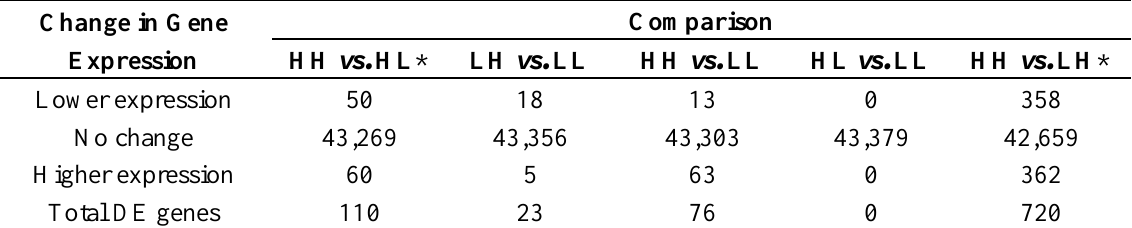
Figure 1. Partial least squares-discriminant analysis (PLS-DA) of gene expression profiles in colon ( left ) and liver ( right ) tissue for genes within the top 5% coefficient of variation; HH (red; n = 6), HL (blue; n = 6), LH (green; n = 6), LL (black; n = 6). Ellipses show 50% confidence interval boundary. Table 2. Summary of gene expression changes in liver tissue in response to altered Se/folate levels. Comparisons for which further analyses, including GSEA, were carried out are marked *. For each of the experimental groups, data represent n = 6 animals. DE = differentially